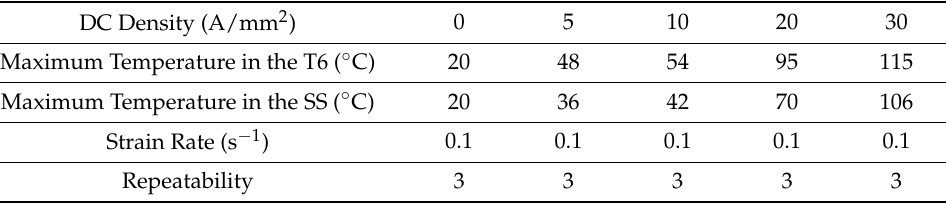
Table 4. Experimental plan of the tensile